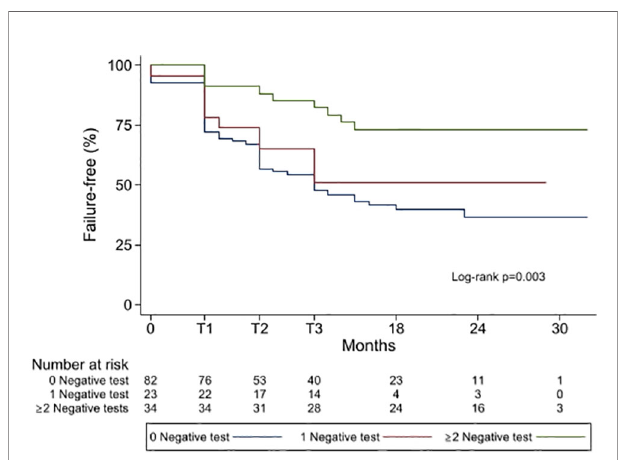
FIGURE 2 | Kaplan – Meier showing failure-free frequencies by group of patient having 0 negative test, 1 negative test or ≥ 2 negative tests. T1 = 4 months, T2 = 8 months, T3 = 12